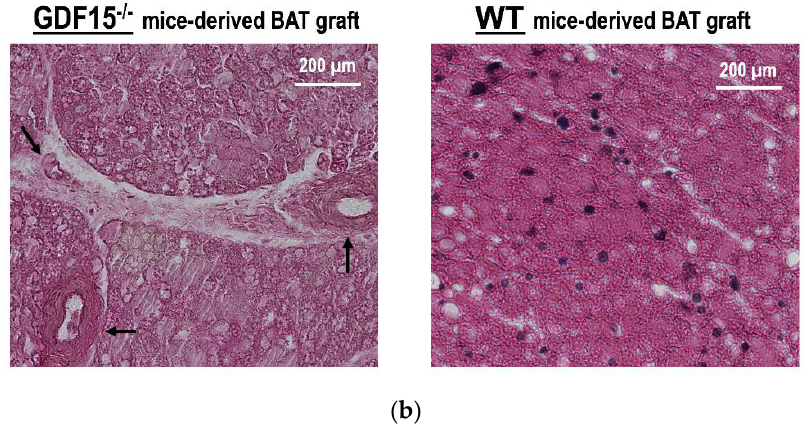
Figure 7. GDF15 is required for long-term survival of BAT grafts. The iBATs of either GDF15 -/- or WT mice were intraperitoneally transplanted into GDF15 - /- mice according to the method presented by Stanford et al. [20]. After 12 weeks, the grafts were removed. ( a ) Macroscopic observations. The BAT grafts of GDF15 - / - mice were shrunk and no angiogenesis was detected ( upper ), whereas those of WT mice retained their sizes and neo-angiogenesis was detected in the soft tissue around the grafts ( lower ). ( b ) Histological observations. Tissue slices of BAT grafts derived from GDF15 - / - mice ( left ) and those of WT mice ( right ) were subjected to HE staining. Structures of the elastic membranes of the arteries were well preserved even in GDF15 -/- -derived BAT grafts (left, arrows).